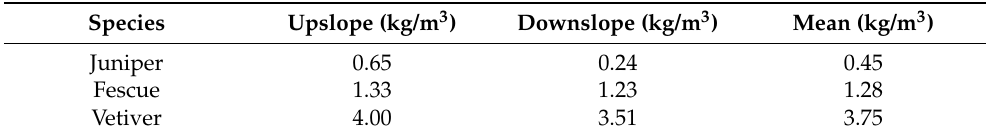
Figure 11. Root biomass by layer for three species in the ( a ) upslope core; and ( b ) downslope core. Table 3. Root biomass by species in the top 40 cm of soil for the upslope core, the downslope core, and the mean of the two cores.